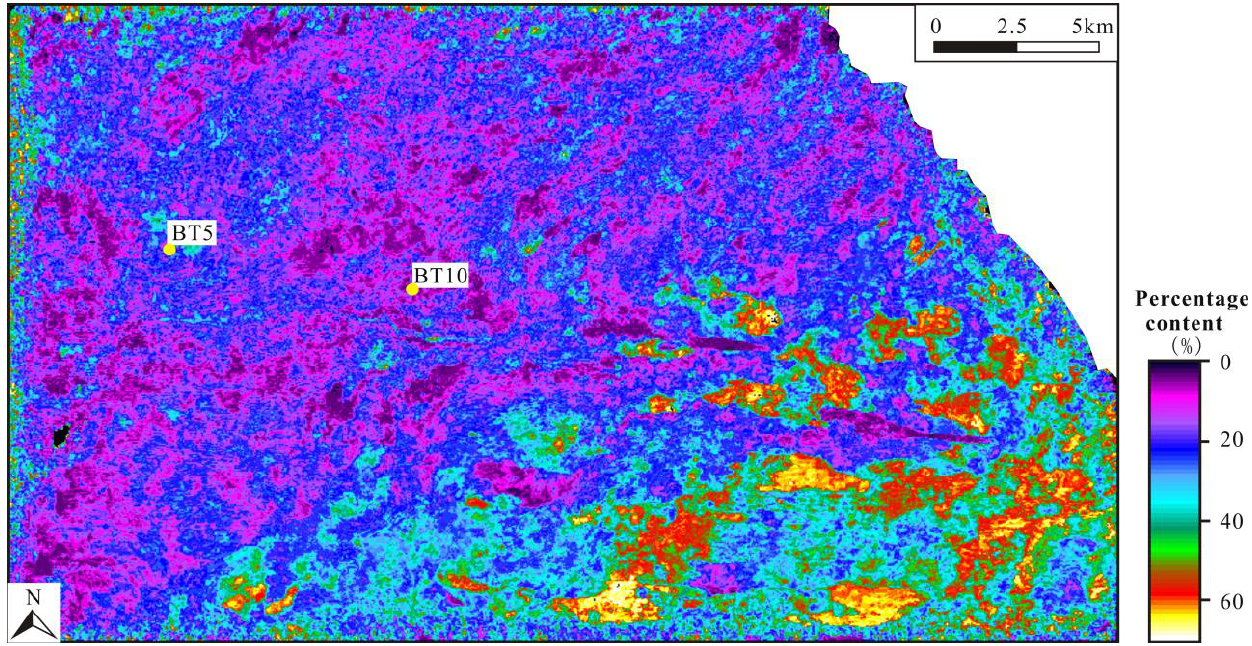
Figure 5. Percentage contents of coal and carbonaceous mudstone in the Karashayi Formation in the BT5 well 3D seismic survey.